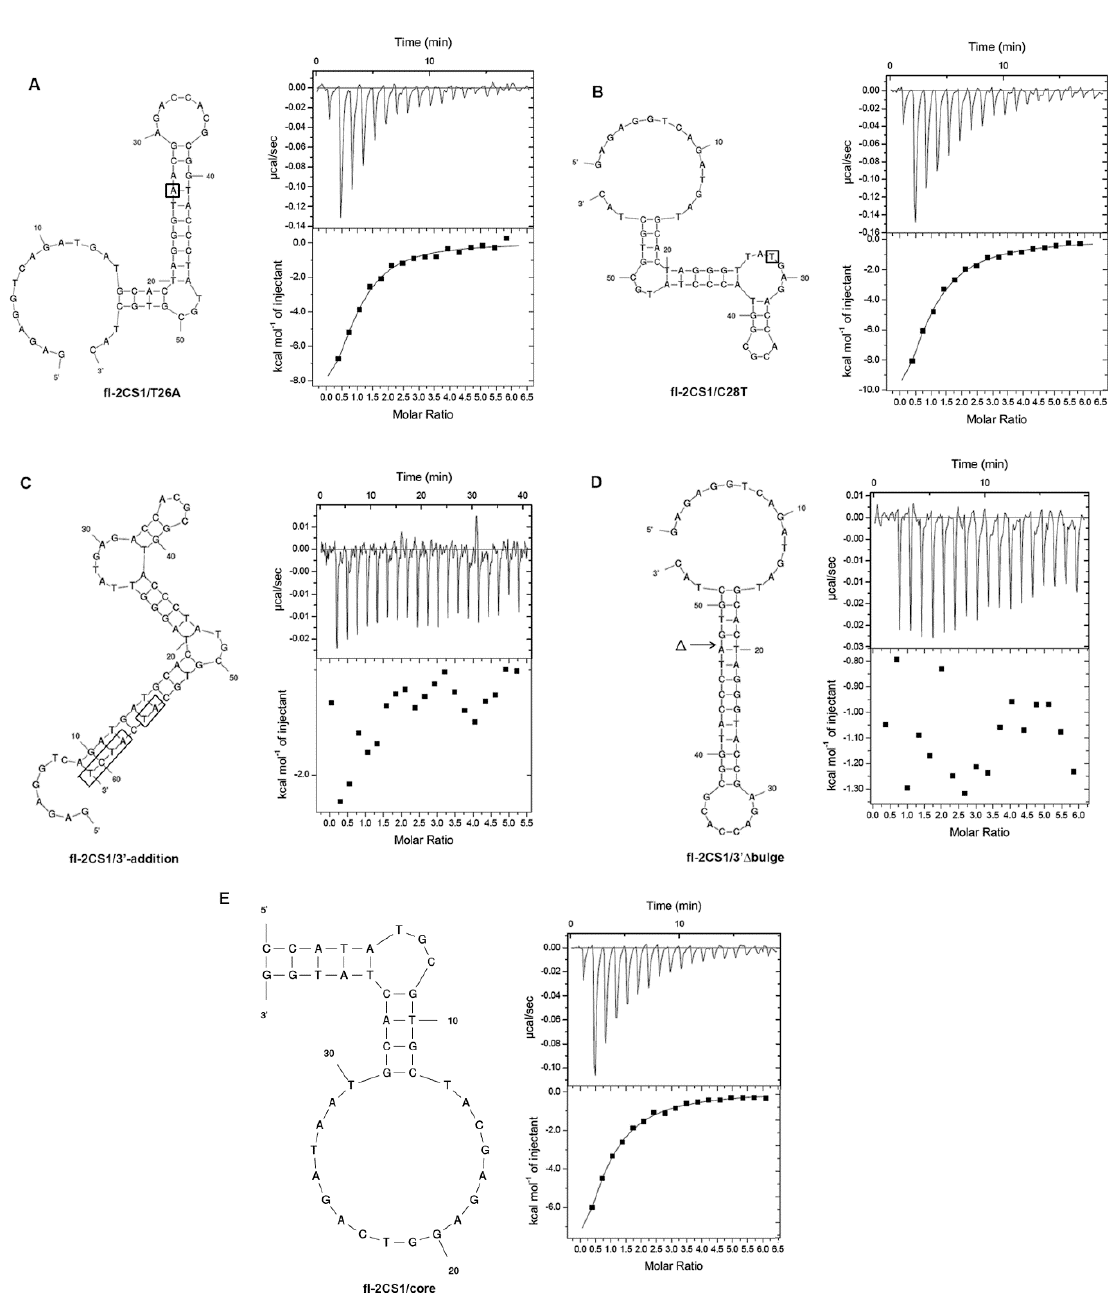
Figure 4. Binding affinity of the fl − 2CS1-derivatives ( A ) fl − 2CS1/T26A, ( B ) fl-2CS1/C28T, ( C ) fl − 2CS1/3 ′ -addition, ( D ) fl − 2CS1/ Δ bulge, and ( E ) fl − 2CS1/core with AFB1 determined by ITC. The mutation sites are boxed or indicted.